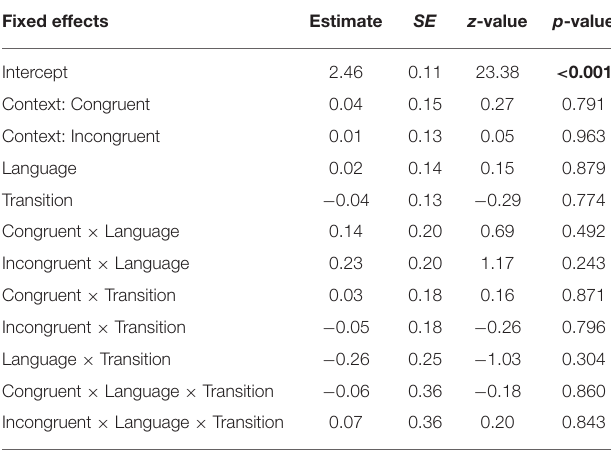
TABLE 5 | Mixed-effects model for